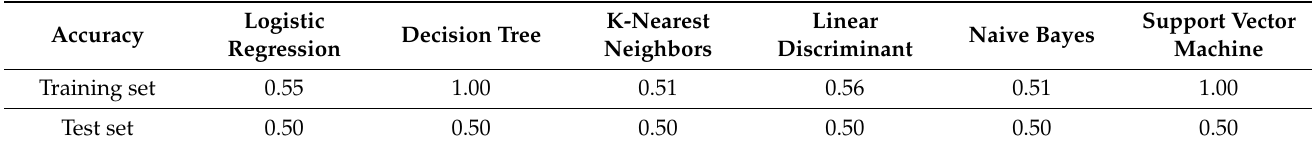
Table 2. Accuracy values for different machine learning algorithms.